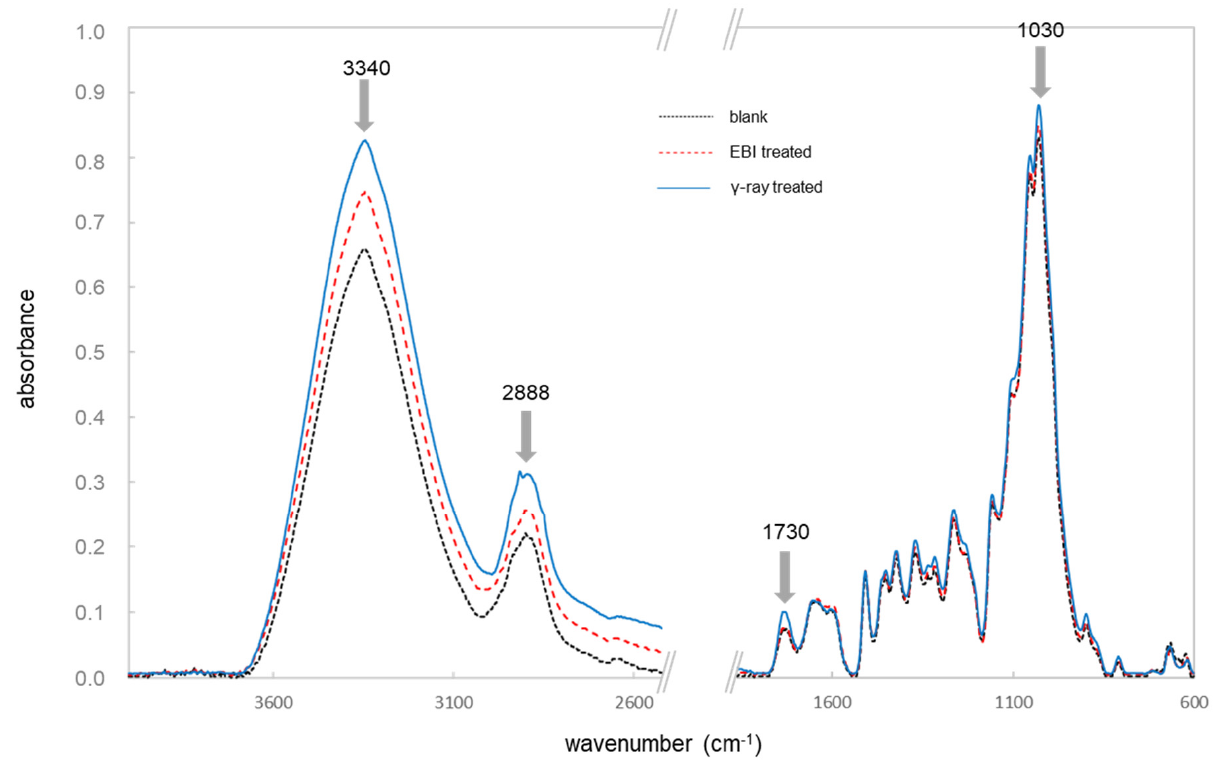
Figure 1. Fourier-transform infrared spectroscopy (FT-IR) spectra of larch sapwood samples with different treatments.